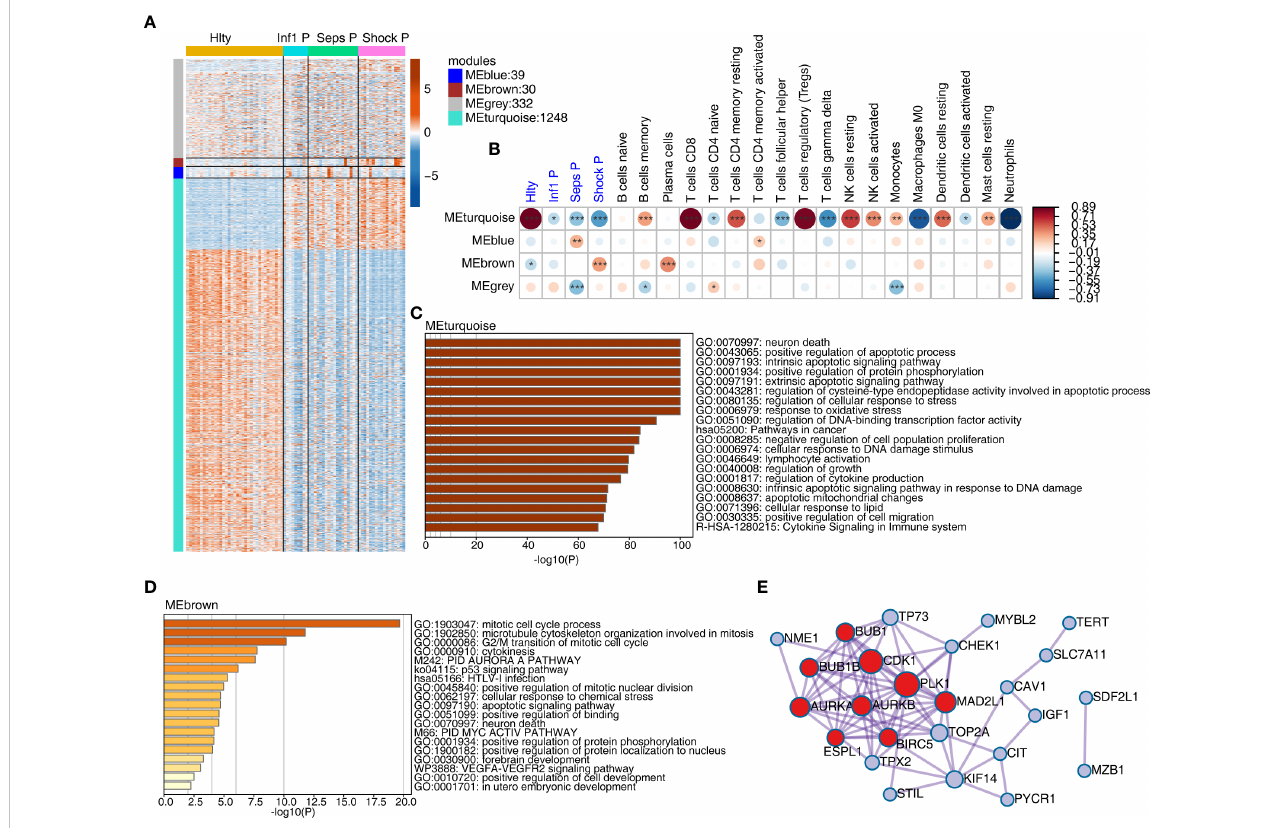
FIGURE 2 Weighted gene co-expression analysis (WGCNA) of cell death-related genes obtained modules associated with sepsis. (A) WGCNA analysis were performed with all expressed cell death-related genes. Heatmap showing expression pro fi le of expressed cell death-related genes. Genes were clustered and sorted according WGCNA modules. (B) WGCNA module-trait associations was computed using ‘ plotEigengeneNetworks ’ function with all factors (disease status and cell fractions) on the x-axis used as covariates. The colors indicate Pearson ’ s correlation value and P-values are displayed with star. *P <=0.05; **P <=0.01; ***P <= 0.001. (C) Functional enrichment of genes from MEturquoise module using Metascape. (D) Functional enrichment of genes from MEbrown module using Metascape. (E) Protein-protein interaction network of genes from